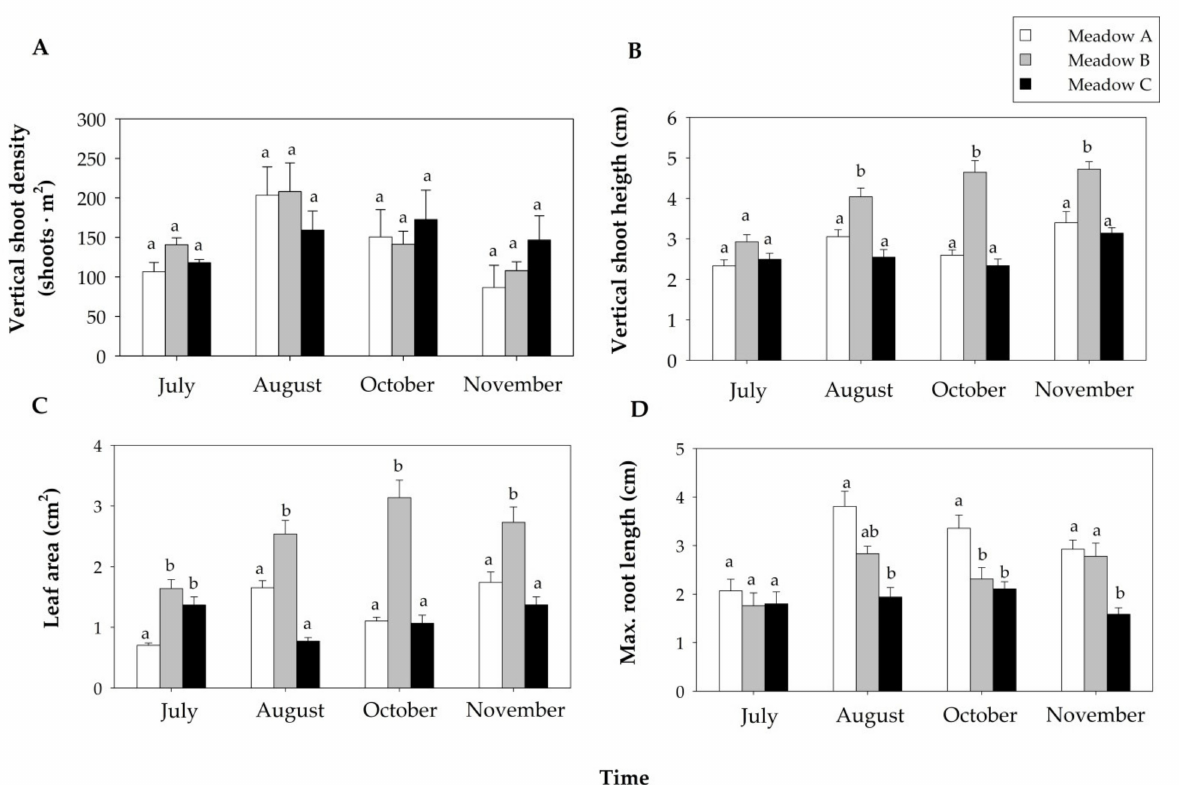
Figure 3. Seagrass biometrics (mean + SE) of the human-dominated Z. noltei meadows during the study period: vertical shoot density (( A ), n = 3), vertical shoot height (n = 6, ( B )), leaf area (n = 6, ( C )) and maximum root length (n = 6, ( D )) Different letters above error bars indicate significant differences among meadows over time.